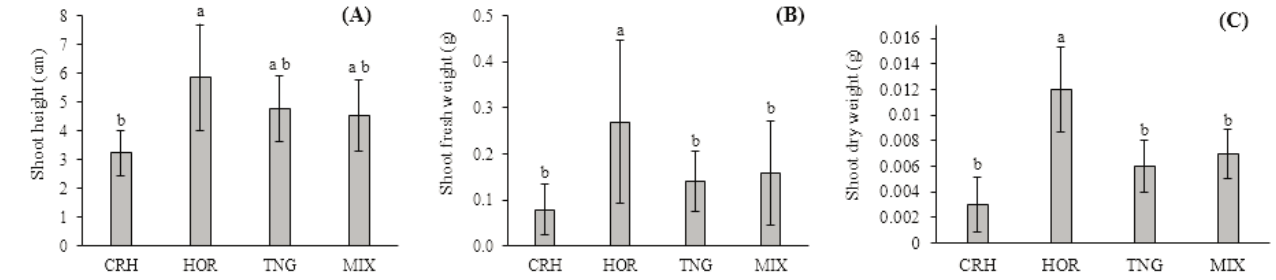
Fig. 4 - Shoot morphology of lettuce seedlings produced in substrates. (A) Shoot height (SH, cm); (B) Shoot fresh weight (SFW, g); (C) Shoot dry weight (SDW, g). Values are means ± standard deviation. Different letters above columns indicate significant differen- ces by the Tukey test (P≤0.05, n = 3). CRH= Carbonized rice hull; HOR= Horta 2®; TNG= TN Gold®; MIX= mixture.